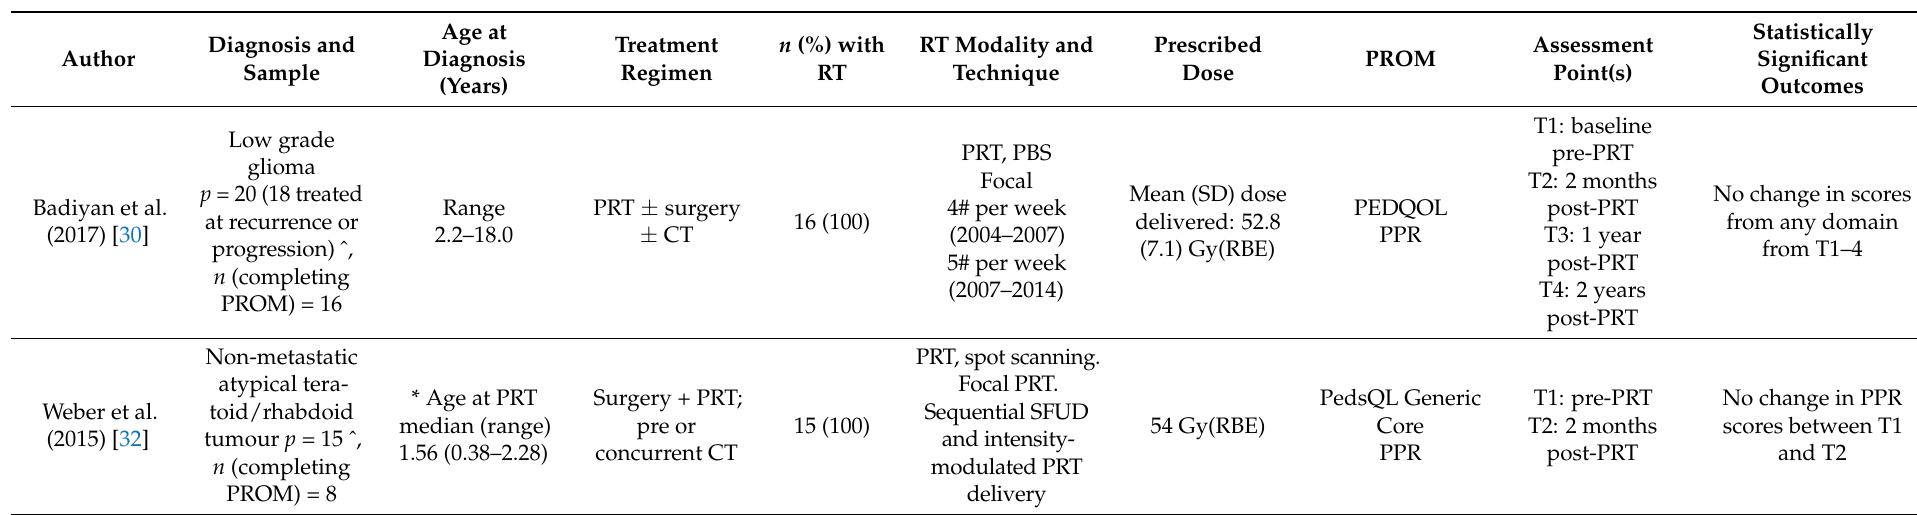
Table 2. Health-related quality of life in survivors of central nervous system tumours treated with proton radiation